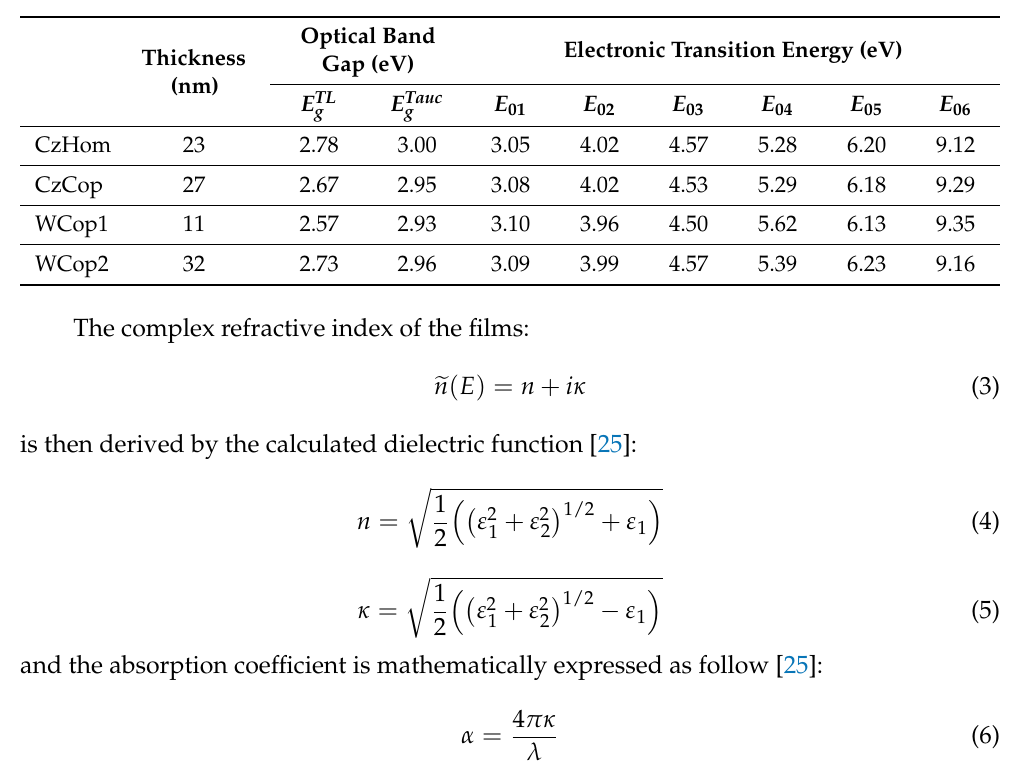
Table 3. The calculated best-fit results derived by the analysis of the measured (cid:104) (cid:101) ε ( E ) (cid:105) spectra of the